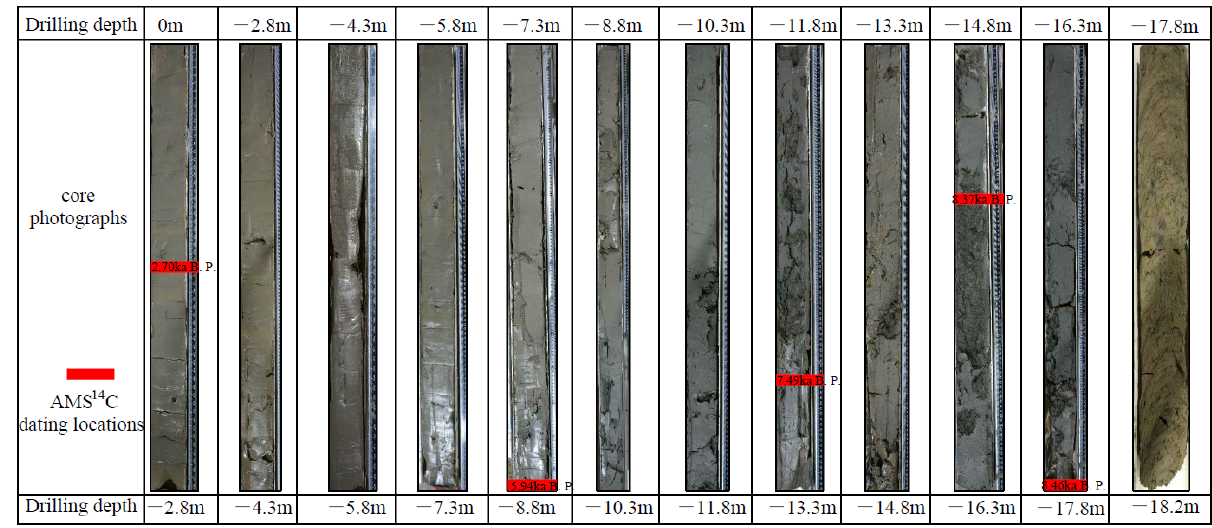
Figure 3. Photos of core WH-05.